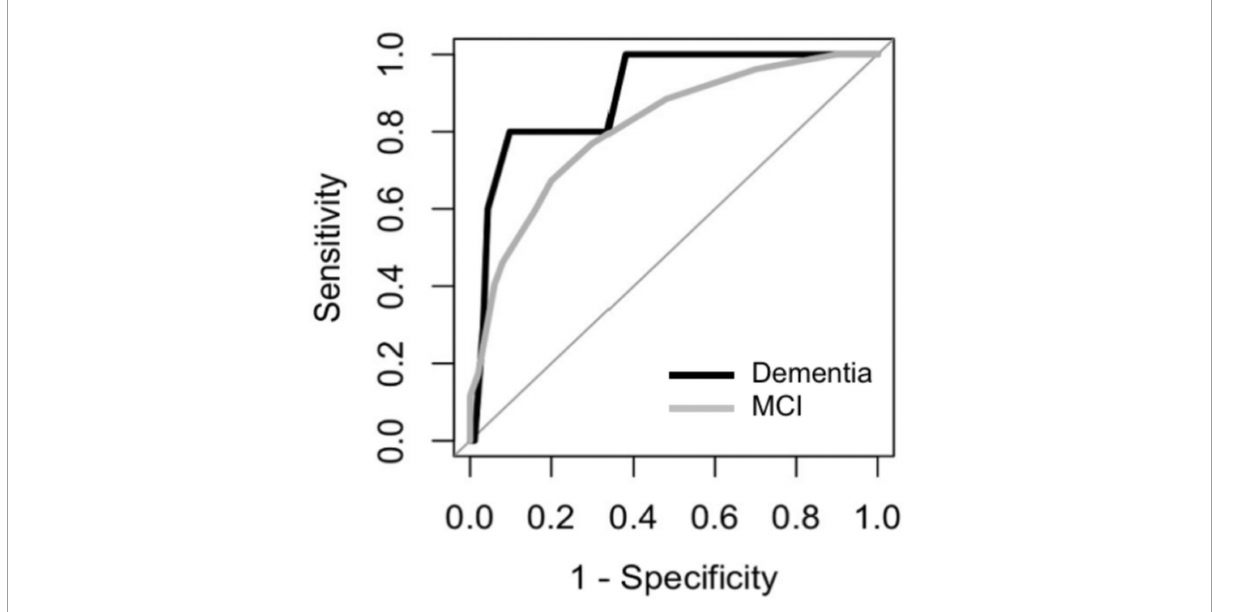
FIGURE5 Receiver Operating Characteristic (ROC) curves of the DCS for discriminating among participants with MCI and dementia.